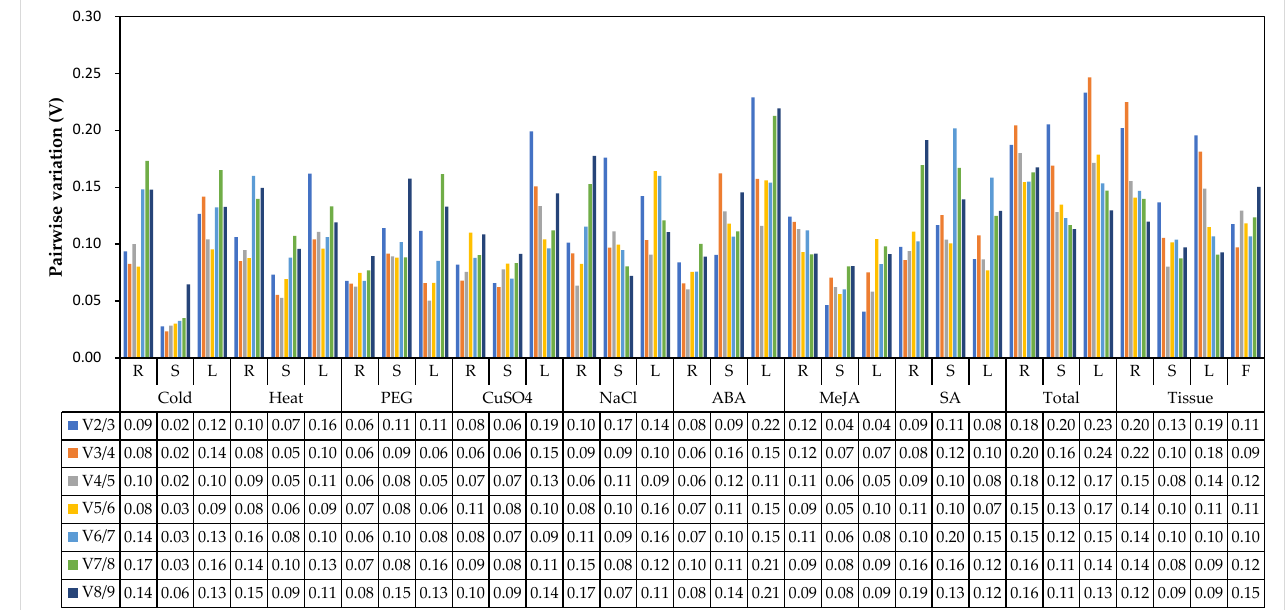
Figure 4. The pairwise variation (V) measures of the nine candidate reference genes using geNorm. Vn/n + 1 values were used to calculate the optimal number of reference genes (n). The letters R, S, L, and F represent root, stem, leaf, and flower, respectively.